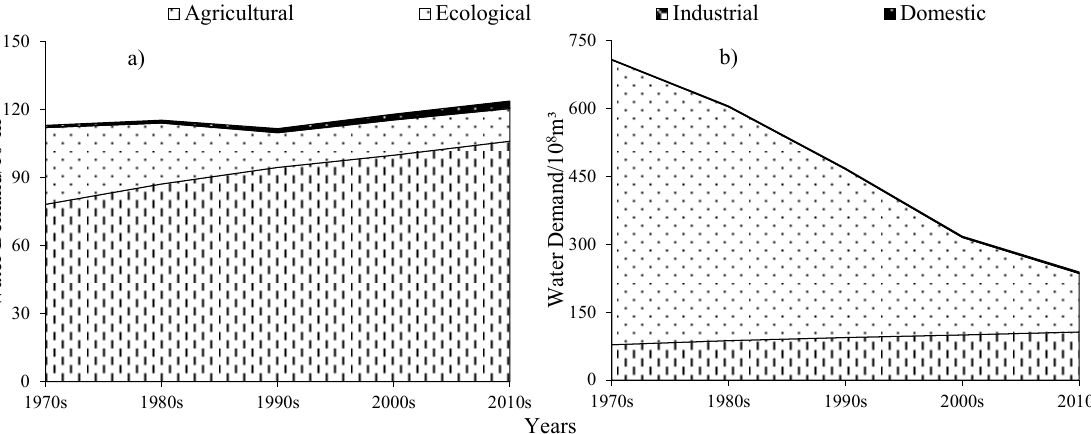
Figure 9. Total of water demand during the 1970s to 2010s. Notes: ( a ) Without EWD of Aral Sea; ( b ) With EWD of Aral Sea.